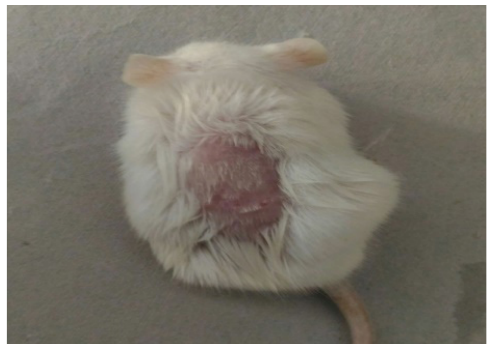
FIGURE 12(b ) - Mice skin for observation of erythema at 24 h.